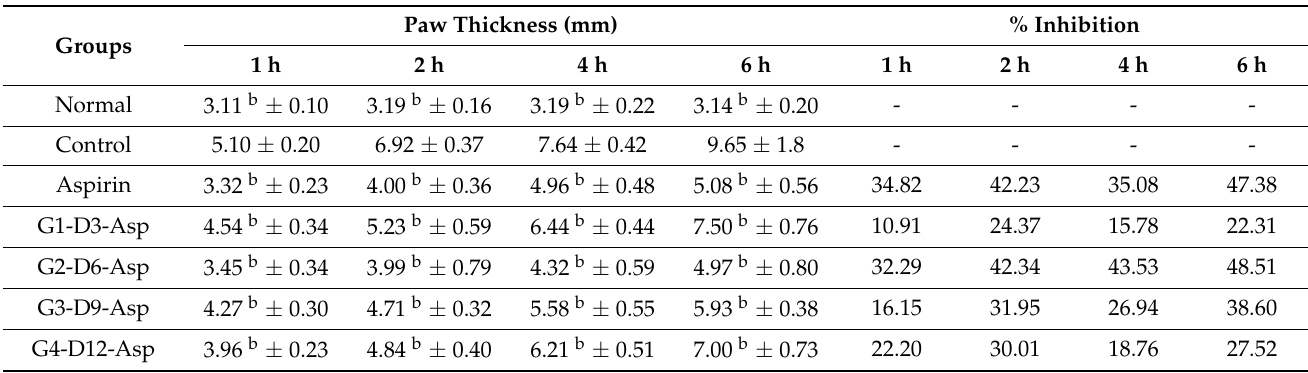
Table 4. The effect of different treatments on carrageenan-induced paw edema at different intervals. Groups